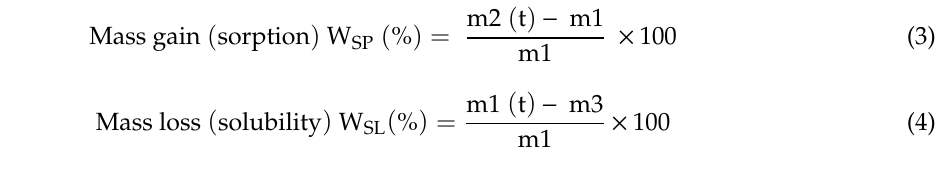
Table 1. Composition of artificial saliva